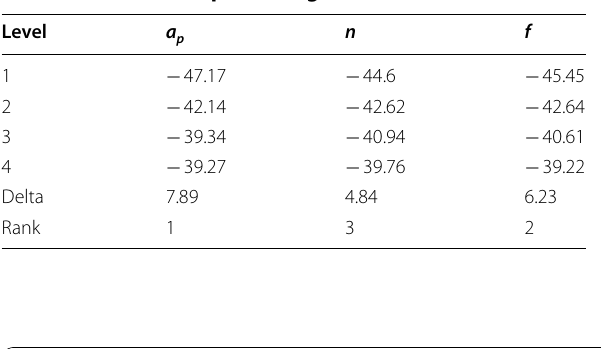
Table 6 S/N ratios of processing time